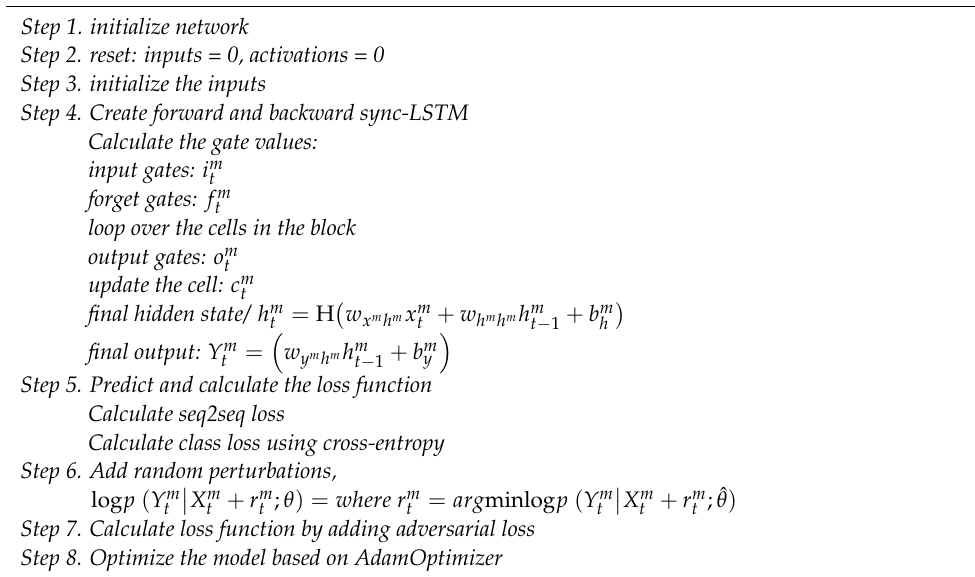
Algorithm 1 Sync-LSTM Model with Adversarial Training